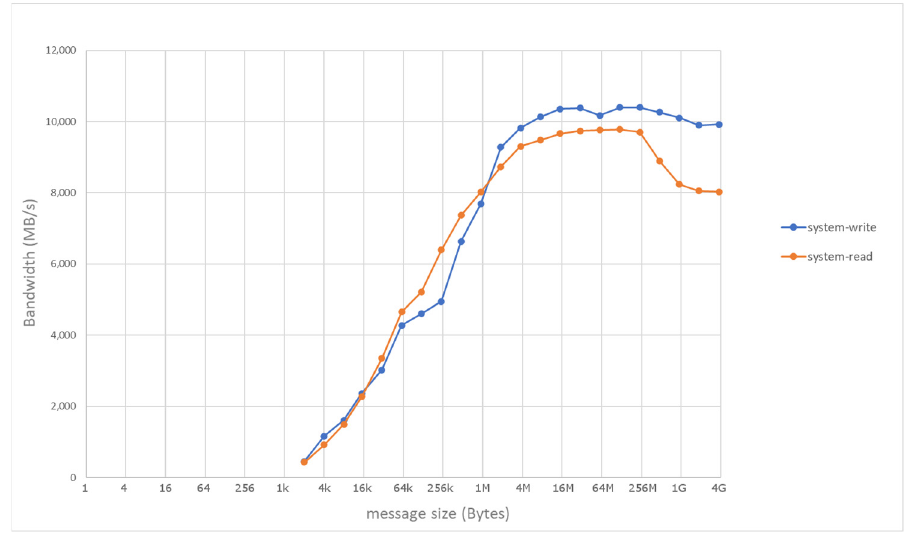
Figure 3. Host-to-host RDMA performance, as measured in the baseline system along Path 1.